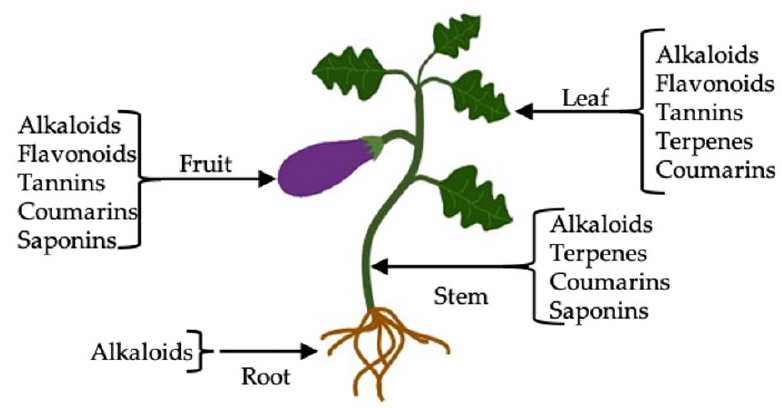
Figure 1. Main metabolites in eggplant organs (residues). Table 1. Phytochemical screening of eggplant agricultural residues. (+) Presence; (−) absence. Metabolite